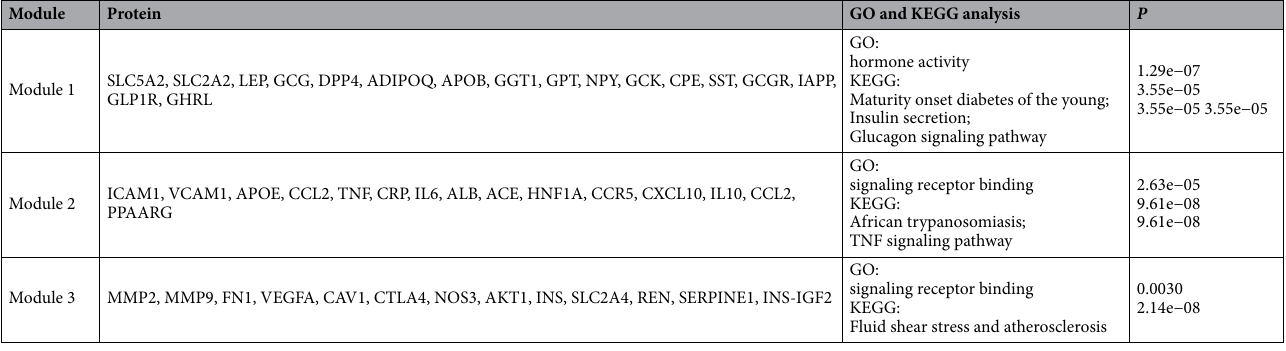
Table 2. GO and KEGG analysis of different modules.